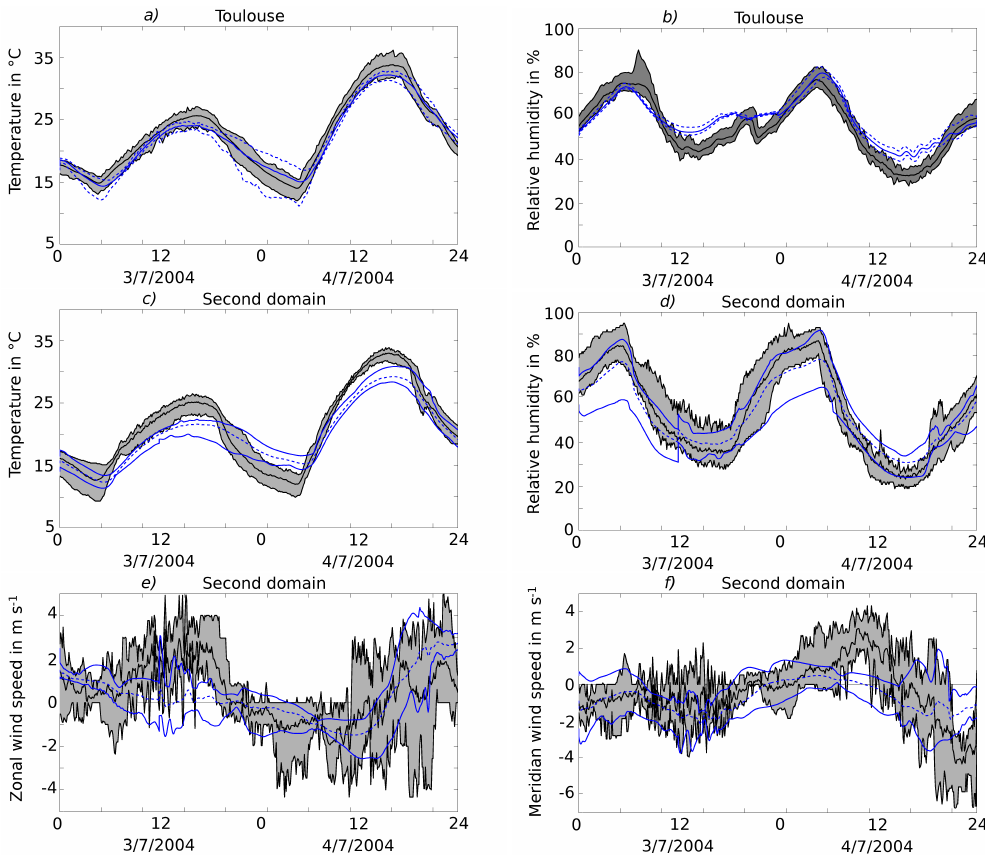
Fig. 5. (a) 2-m temperature in ◦ C and (b) relative humidity in % observed by 21 stations located over Toulouse and modeled. (c) 2-m temperature in ◦ C, (d) relative humidity in %, (e) zonal and (f) meridian wind in ms − 1 observed by the meteorological stations located at the regional cities: Agen, Castres, Saint-Gaudens and Carcassonne. The envelope which encompass all the observed values are in gray area. The average value for observations is drawn in black line. The minimum and maximum modeled values are drawn in continuous blue line, and the average value is drawn in dashed blue line. All the model values result from the 500-m resolution domain computations.